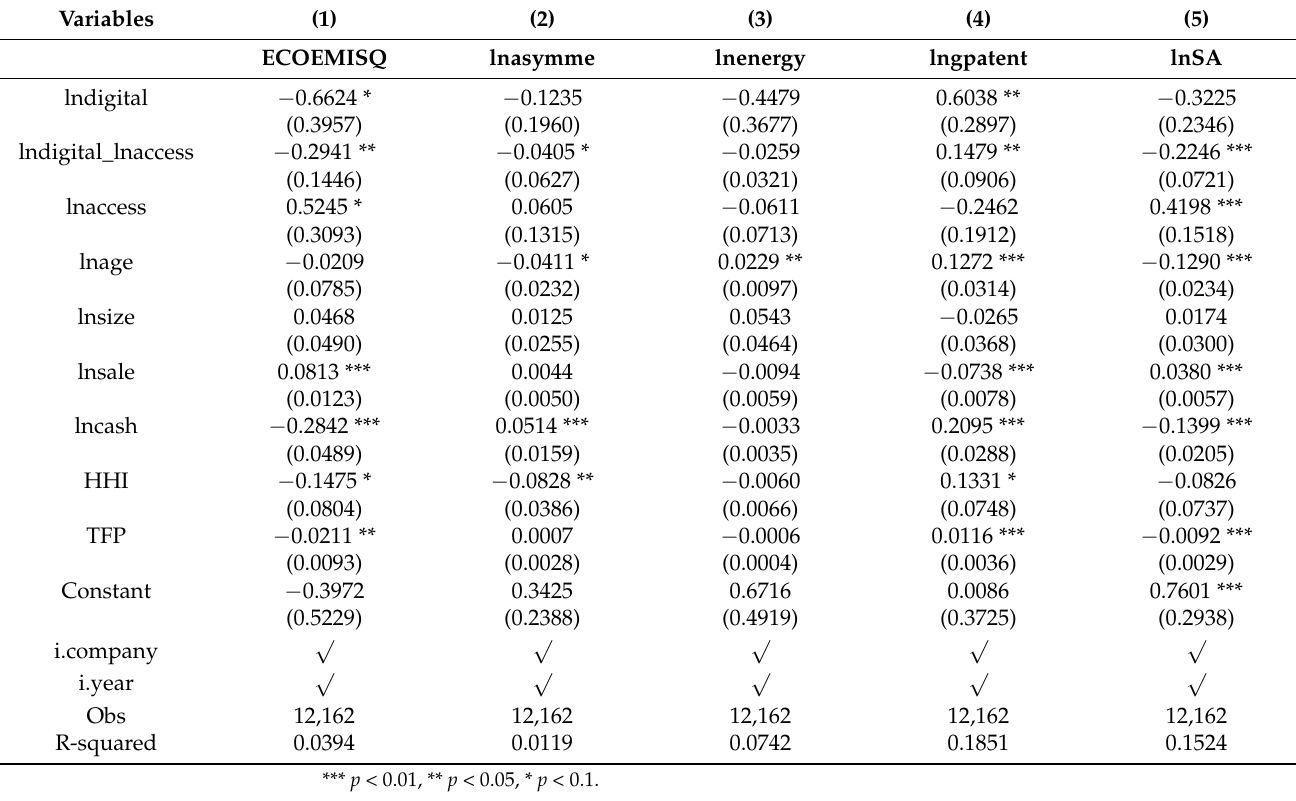
Table 12. Moderating effect of digital information resources.